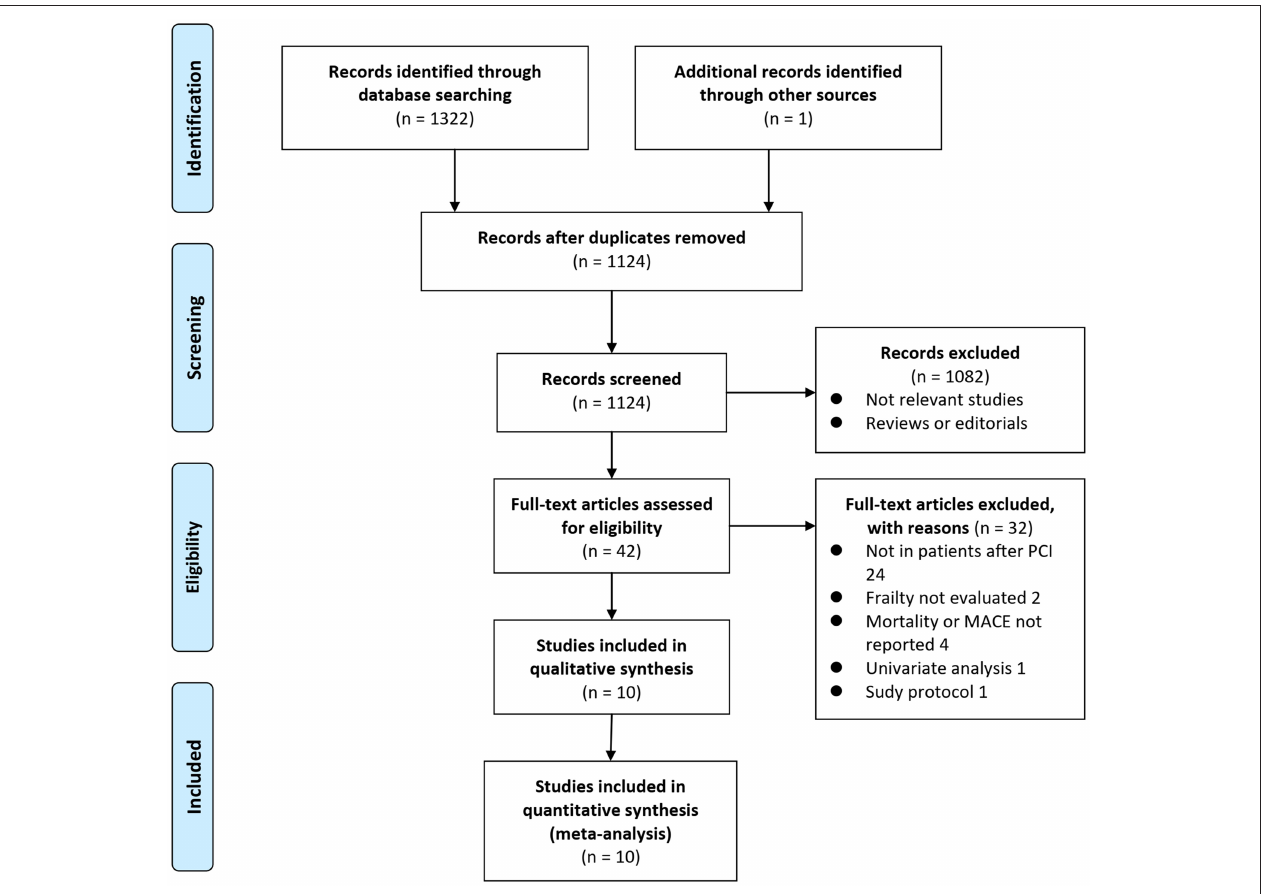
FIGURE 1 | Scheme of study